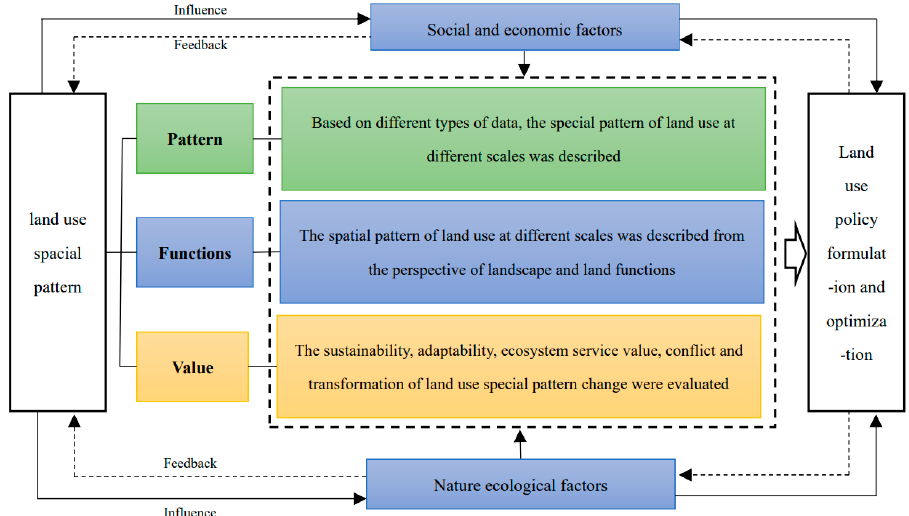
Figure 9. Transformation of spatial pattern of land use optimization.